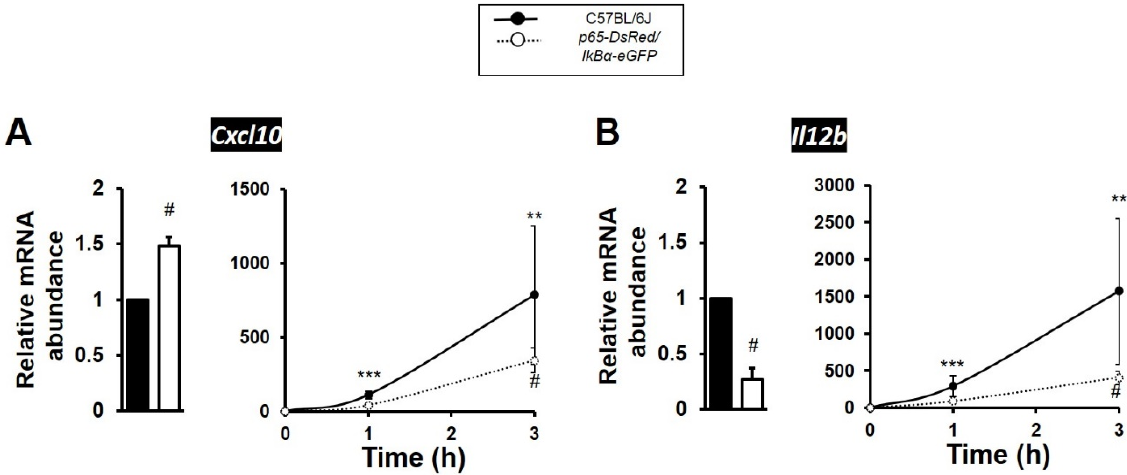
Figure 4. NF κ B regulated cytokines/chemokines show decreased gene expression levels in TLR4 activated p65-DsRedxp/I κ B α -eGFP bone marrow-derived macrophages (BMDMs). Bone marrow cells from frozen stocks were differentiated in vitro to macrophages as described in Materials and Methods. C57BL/6J and transgenic BMDMs were left unstimulated or were stimulated with LPS (100 ng/mL) for a time course up to 3 h. Total RNA was purified, and the samples were analysed by qPCR for the expression of ( A ) Cxcl10 and ( B ) Il12b ; with the left hand panel showing a histogram of fold change in mRNA levels in untreated transgenic BMDMs (white bar) relative to C57BL/6J controls (black bar), and the right hand panel showing dynamic changes in gene expression following treatment with LPS relative to respective unstimulated control or transgenic BMDMs. Significant differences to unstimulated BMDMs, ** p < 0.01 and *** p < 0.001; or stimulated transgenic, # p < 0.05 (Kruskal–Wallis test; n = 3 mice, n = 2–3